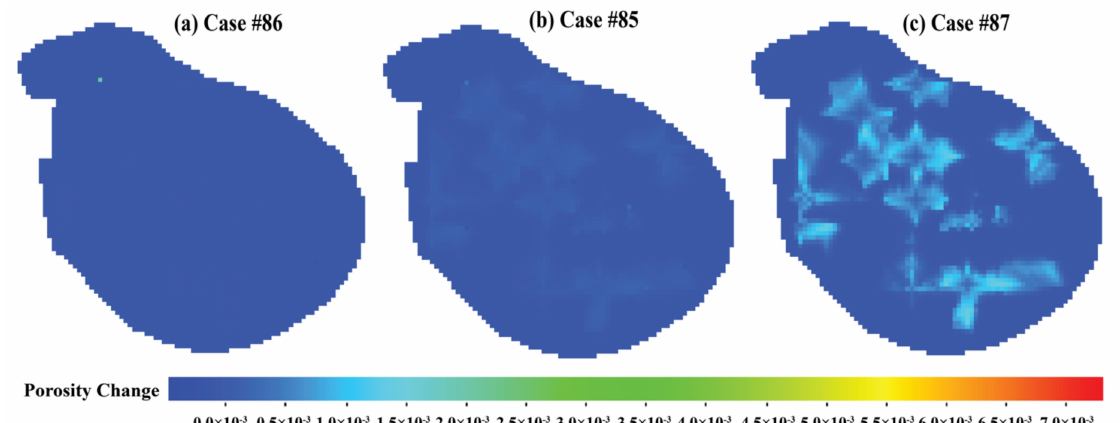
Figure 6. Estimated porosity loss at the end of the CO 2 -EOR period compared to the initial values for ( a ) Case #86, ( b ) Case #85, and ( c ) Case #87.